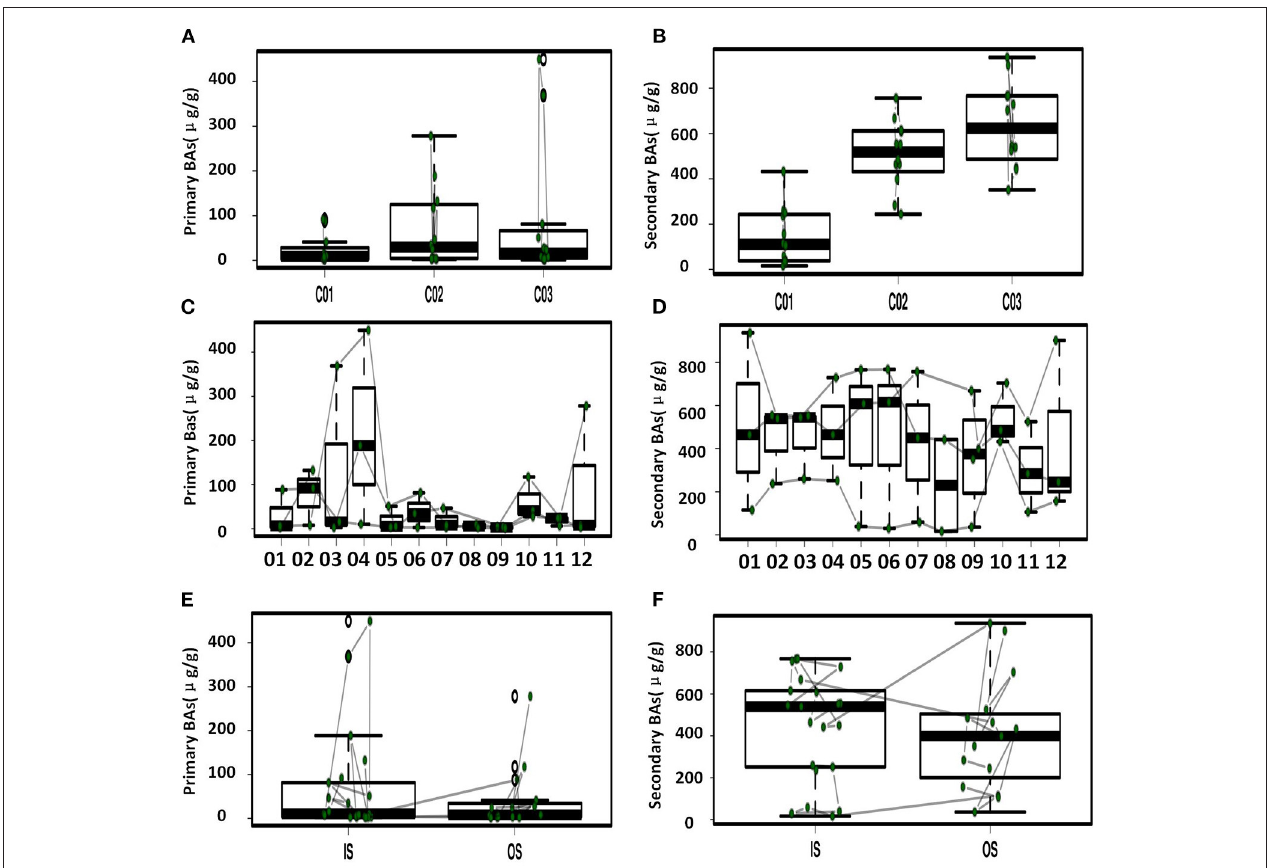
FIGURE 3 | Primary and secondary BAs in feces with significant difference. (A) Comparison of primary BAs for the three crewmembers. (B) Comparison of secondary BAs for the three crewmembers. (C) Temporal variation of primary BAs at the different sampling time points. (D) Temporal variation of secondary BAs at the different sampling time points. (E) Comparison of primary BAs in the simulator (IS) and out of the simulator (OS). (F) Comparison of secondary BAs IS and OS.